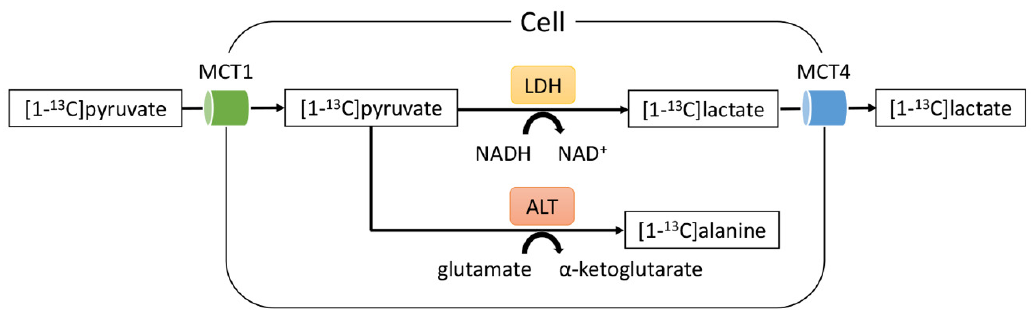
Figure 1. Diagram of the metabolic fates of [1- 13 C]pyruvate that were detected by hyperpolarized 13 C-MR spectroscopy in this study. Note—MCT, monocarboxylate transporter; LDH, lactate dehydrogenase; ALT, alanine transaminase.